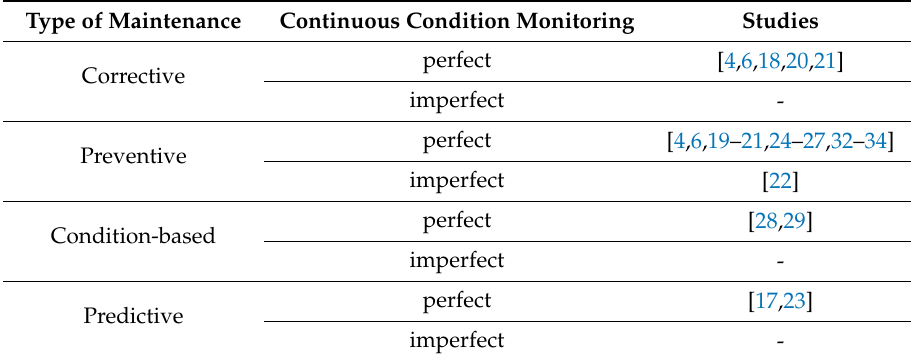
Table 1. Classification of maintenance models on the basis of continuous condition